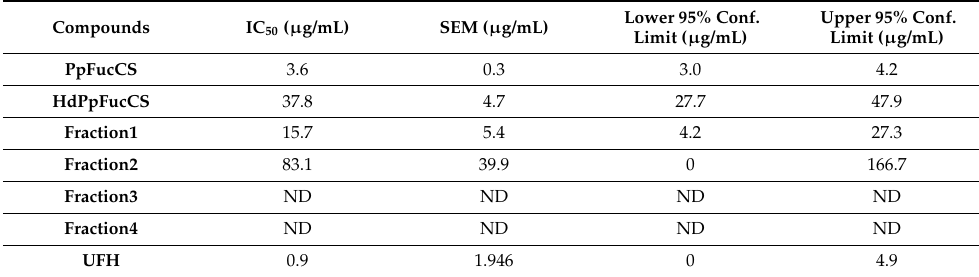
Table 1. IC 50 values of anti-viral activities of PpFucCS and its oligosaccharides. The IC 50 values of anti-HCMV inhibitory activity of PpFucCS and its oligosaccharides were determined in HFFs. Considering the role of avidity often found in protein–glycosaminoglycan (GAG) interactions and the broad range of molecular weights of the compounds, IC 50 values were measured in terms of µ g/mL rather than the molar units. ND, not detected. Compounds IC 50 ( µ g/mL) SEM ( µ g/mL)